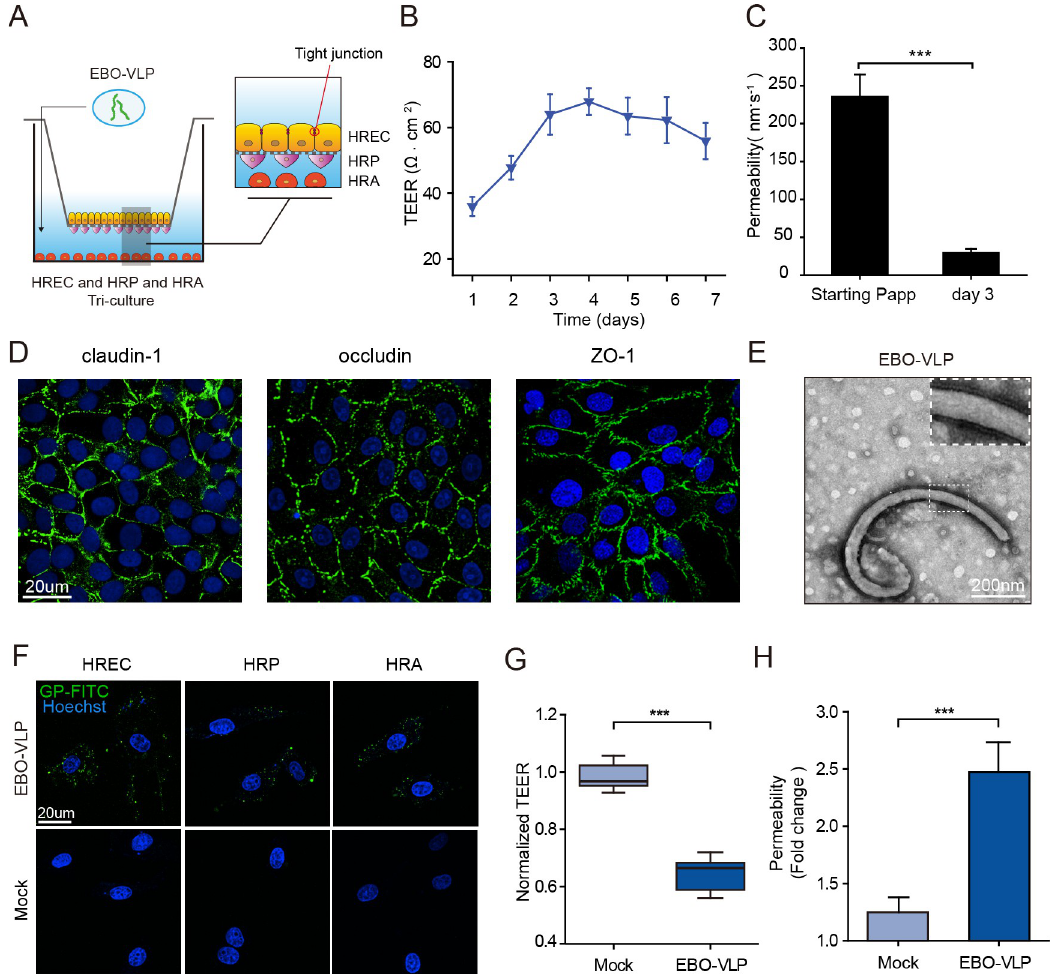
Fig 1. EBO-VLPs disrupt the iBRB in the in vitro model. (A) Schematic overview of the iBRB tri-culture model in a Transwell system of HREC, HRP and HRA. EBO-VLPs were added to the lower chamber of the tri-culture iBRB model, which represents the retinal tissue. (B) Assessment of the integrity of the in vitro barrier models by TEER every day for one week. The results are presented as the means ± standard deviation of six independent experiments. (C) Na-F permeability of iBRB tri-culture models at 6 hours and 3 days post HREC seeding. The results are presented as the means ± standard deviation of six independent experiments. (D) Images of HREC showing the expression of claudin-1, occludin, and ZO-1. Claudin-1, occludin, and ZO-1 are shown in green, and cell nuclei were stained with DAPI (blue). Representative images of three independent experiments are shown. (E) TEM images of EBO-VLPs. (F) Images of HRECs, HRPs and HRAs treated with EBO-VLPs and immunostained with anti-GP antibodies (green). Cell nuclei were stained with DAPI (blue). Representative images of three independent experiments are shown. The fluorescent images were taken with a 60 × magnification objective lens under a confocal microscope. (G-H) Integrity of the tri- culture iBRB model after EBO-VLP administration. TEER values (G) and Na-F permeability (H) of the iBRB model were examined at 48 h after EBO-VLP administration. TEER values were normalized to those of iBRB models themselves before EBO-VLP administration. The box and the whisker present the median ± percentiles (25–75%) and range, respectively. The fold change of permeability compared with iBRB model itself before EBO-VLP administration is presented as the mean ± standard deviation. All values were determined in six independent experiments. Statistical analysis was performed using Student’s t test. ��� p <